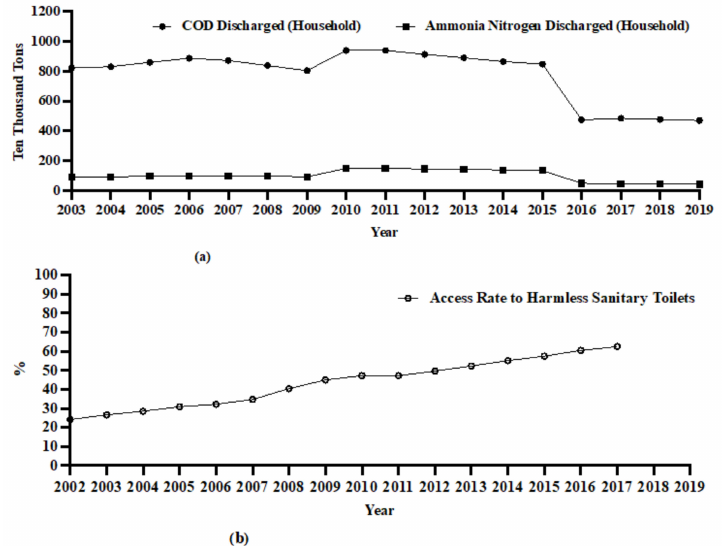
Figure 2. Discharge of wastewater (ten thousand tons) and access rate to harmless sanitary toilets (%). ( a ) COD and Ammonia Nitrogen in sewage discharge (Household). ( b ) Access Rate to Harmless Sanitary Toilets (%). Source: China Environmental Statistical Yearbook